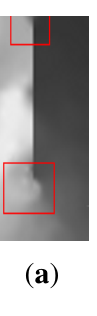
Figure 17. ( a ) Detailed section of Figure 15 showing the area around the obstacle with artefacts marked in red. ( b ) Detailed section of Figure 16 showing the area around the